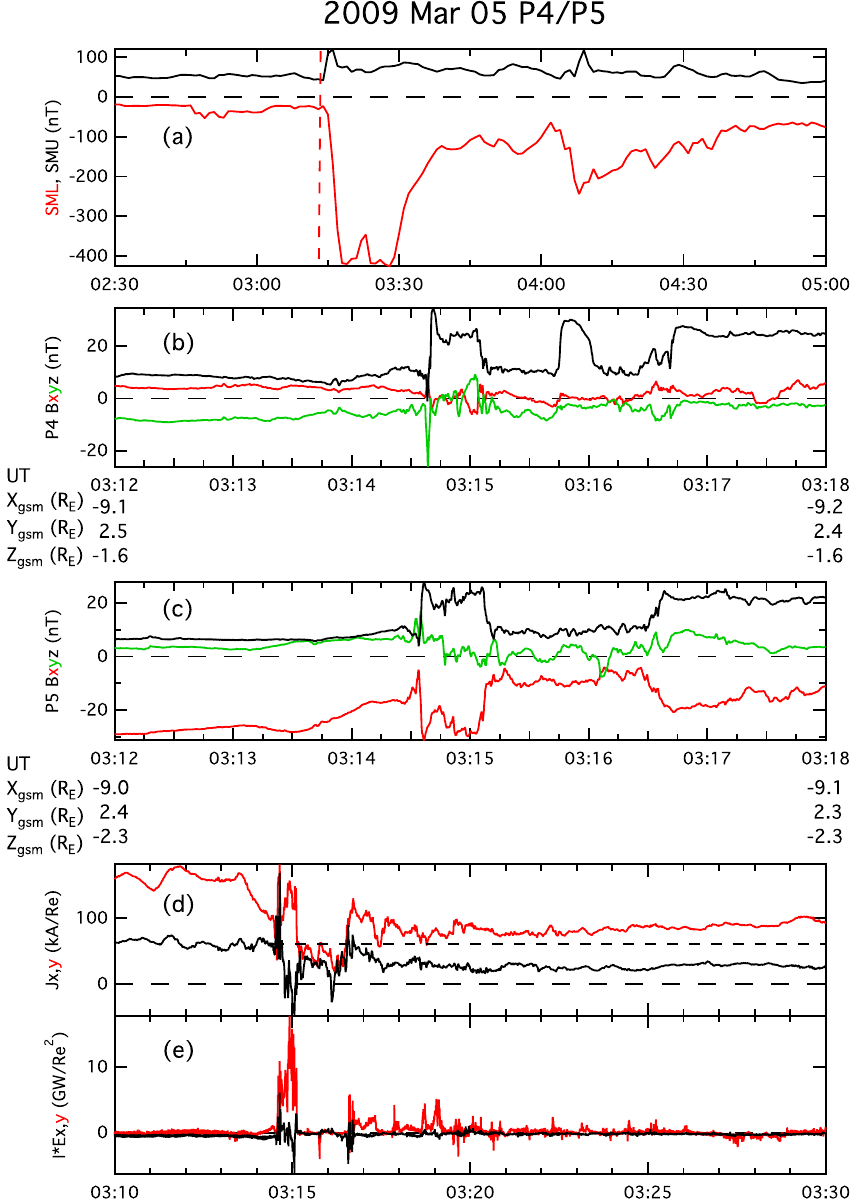
Fig. 5. Observations of the current disruption/dipolarization event on 5 March 2009. The parameters shown and the format are same as Fig. 1.